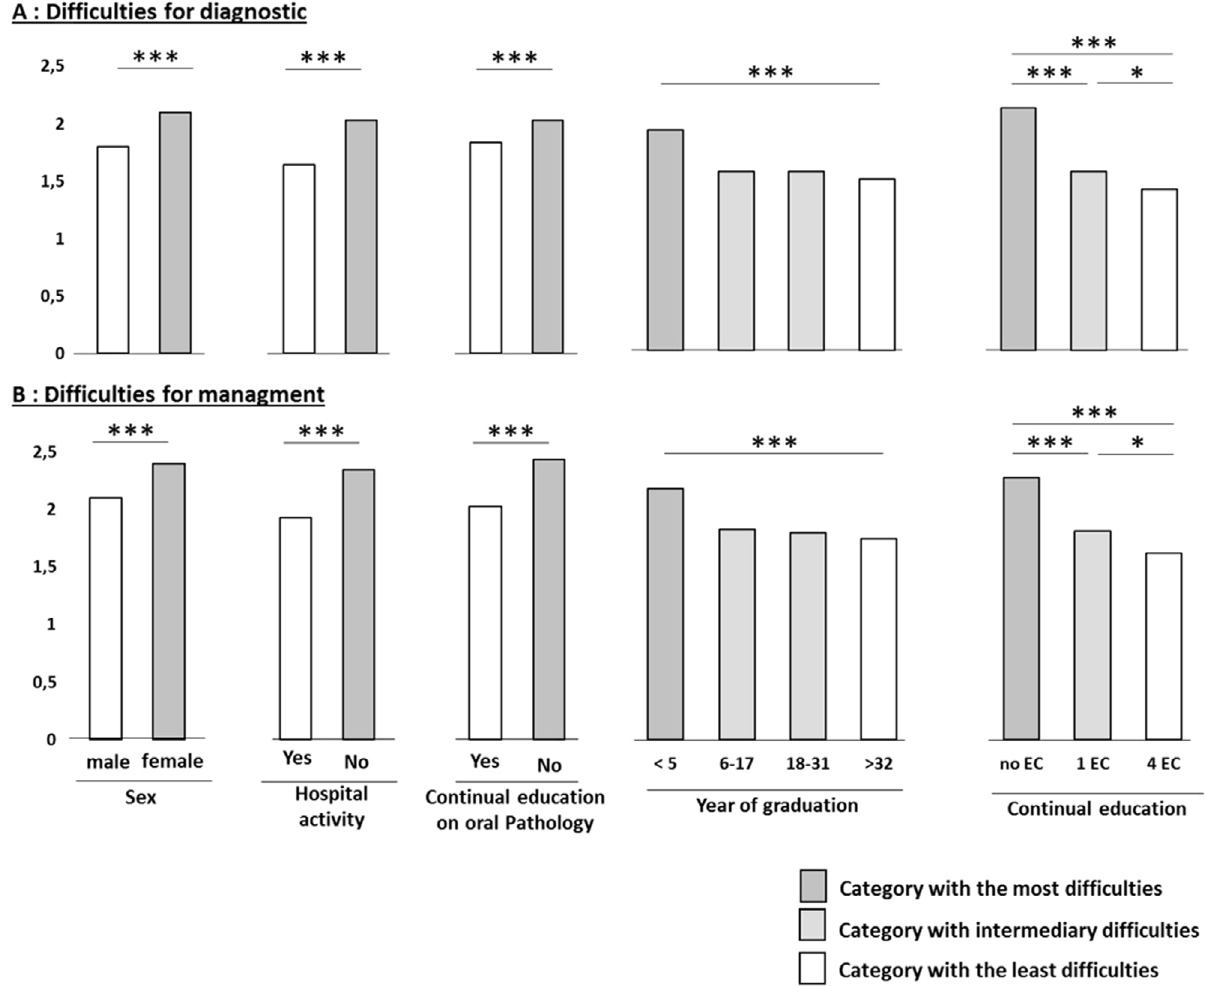
Fig. 4. Variation of practitioner ’ s dif fi culties in diagnosing and managing the pathologies of the oral mucosa according to sex, hospital activity and continual education. (a) Dif fi culties of diagnosis according to gender, hospital activity and continual education. The white zone represents the category with the least dif fi culties, the light grey zone intermediary dif fi culties and the darkgrey zone the most dif fi culties. (b) Dif fi culties of management according to gender, hospital activity and continuing education. The white zone represents the category with the least dif fi culties, the light grey zone intermediary dif fi culties and the dark grey zone the most dif fi